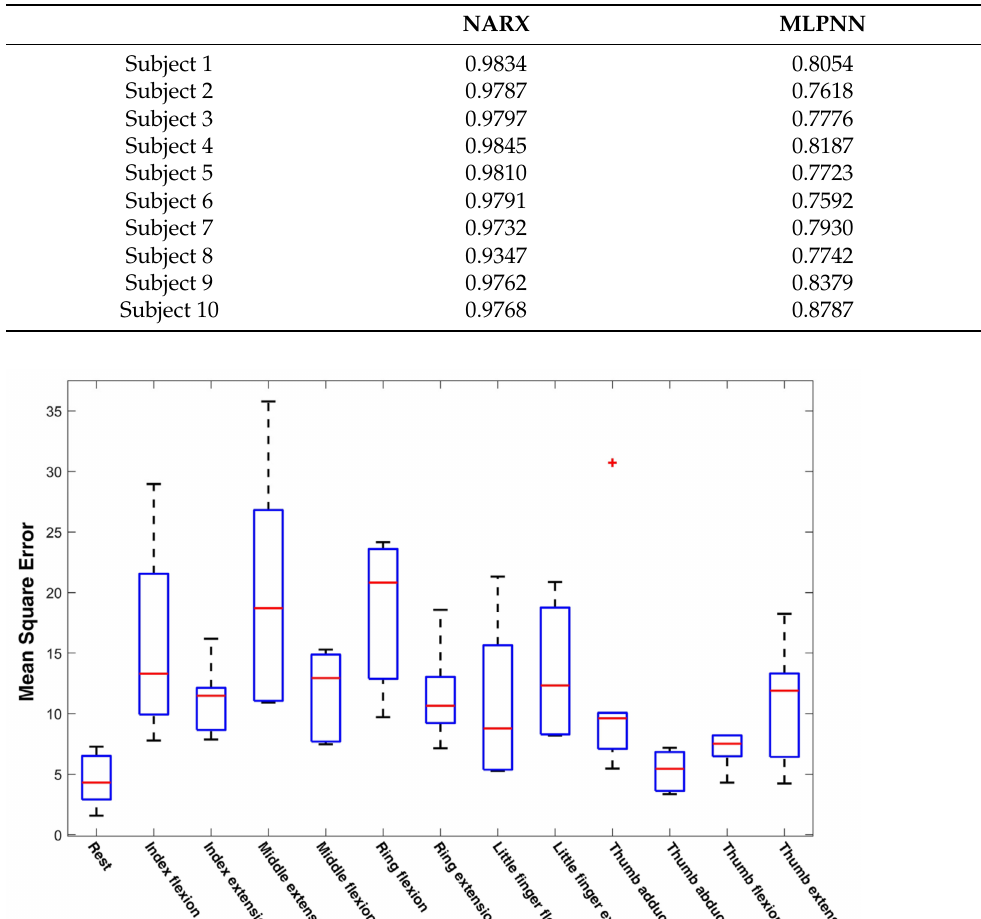
Table 3. Regression value of outputs of the NARX model and ordinary MLPNN model over subjects.